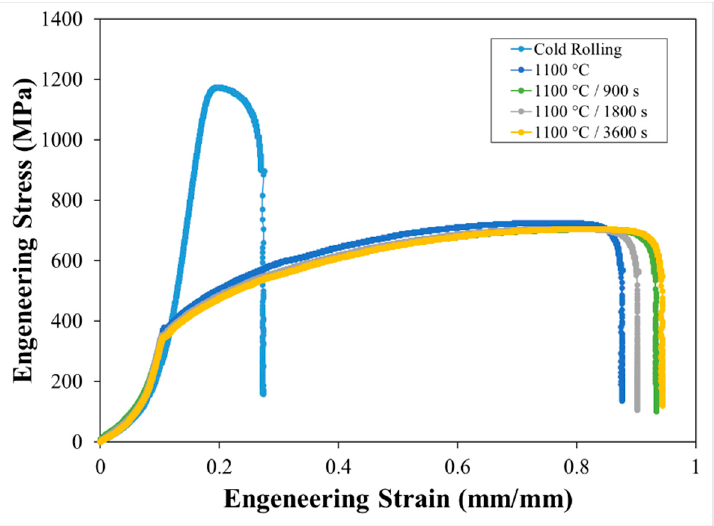
Figure 6. Engineering stress vs. engineering strain of 253 MA ASS after cold rolling and annealing with variations in the annealing time.